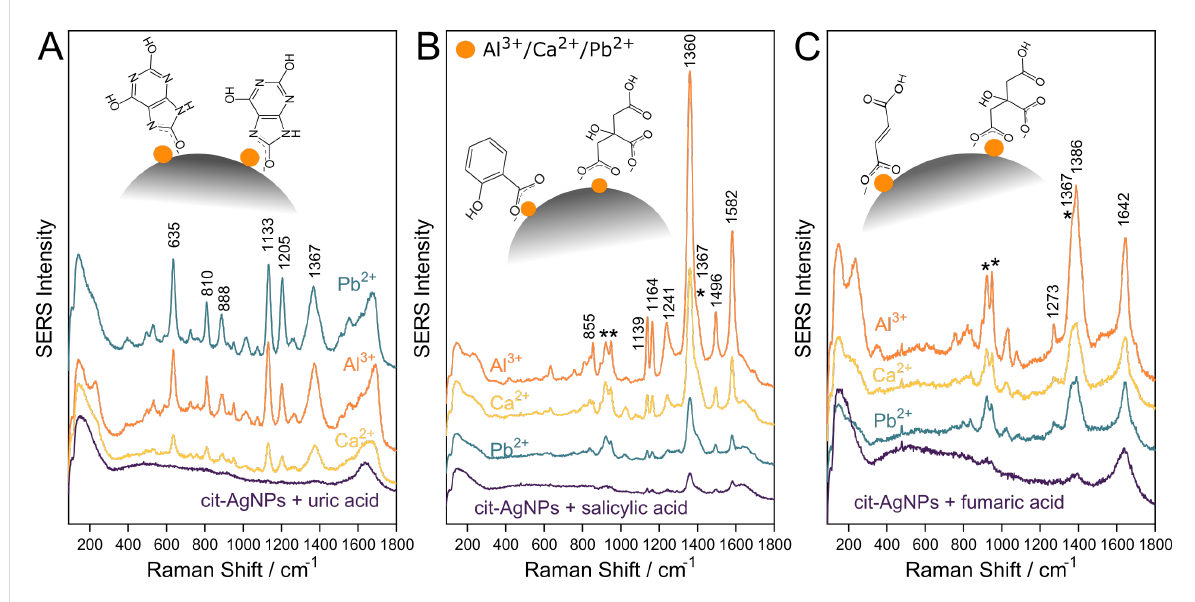
Figure 2: SERS spectra of 50 µM organic acids after their addition to cit-AgNPs and after the activation of the AgNPs with 50 µM Ca 2+ , Pb 2+ or Al 3+ , as indicated in the figure: (A) uric acid, (B) salicylic acid and (C) fumaric acid. The insets show the proposed chemisorption geometry of the anionic analytes on the silver surface. Contributions to the spectra from the citrate capping agent are marked by